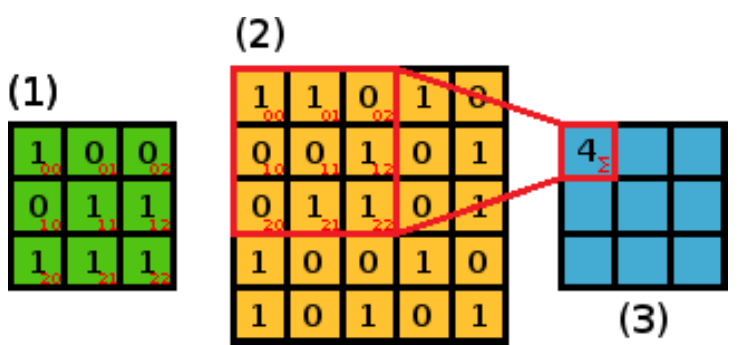
Figure 2. Calculation of the first component of a feature map (3), with a 3 × 3 filter (1) applied to 5 × 5 data (2). The red square within the input data (2) represents the actual region, where the filter (1) is applied to produce the first component of (3) according to Equation